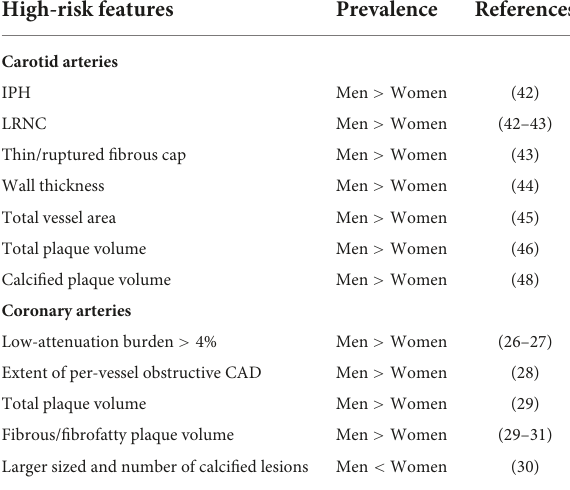
TABLE 3 Difference between men and women of high-risk plaque features in carotid and coronary arteries. High-risk